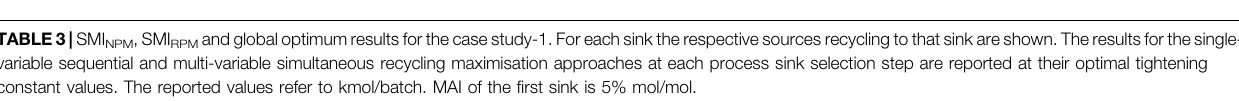
(Single-variable sequential) Optimal tightening constant: